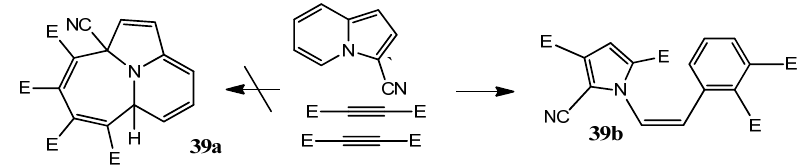
Scheme 17. Structure of 1:2 adduct of 3-cyanoindolizine and DMAD.